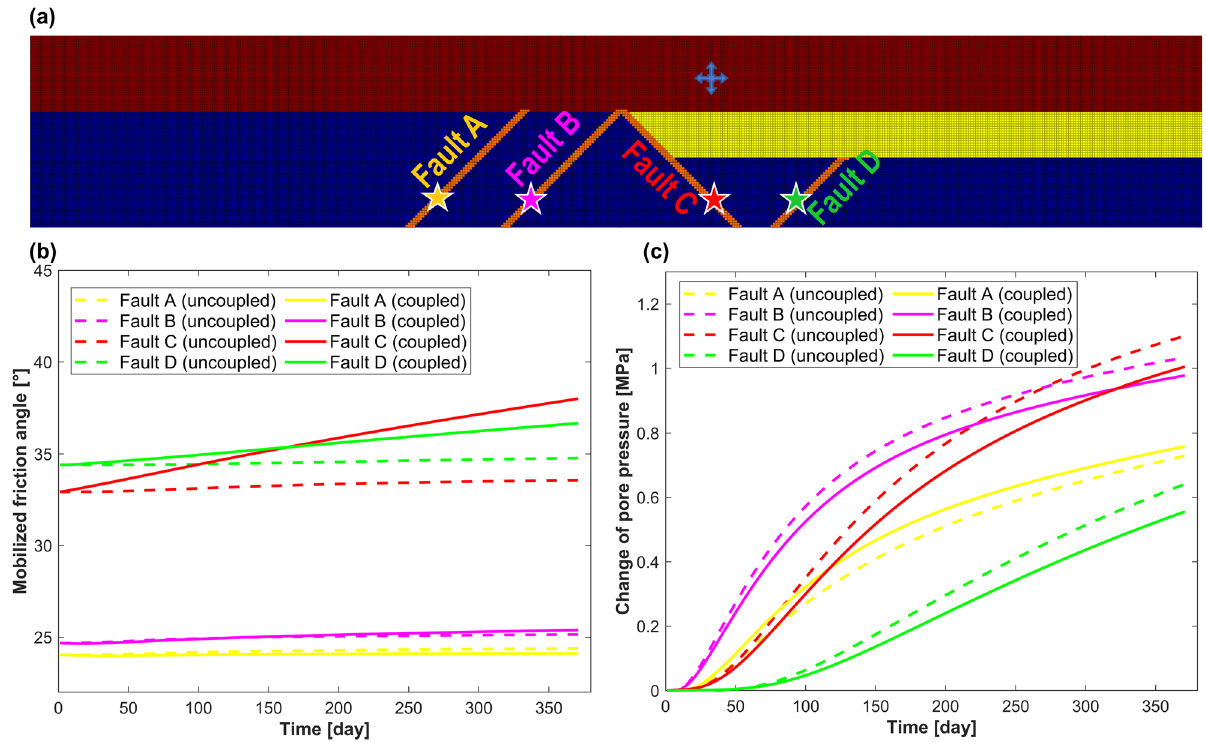
Figure 7. ( a ) Location of the monitoring points in the faults, ( b ) change of mobilized friction angle at monitoring points, and ( c ) change of pore pressure at monitoring points.